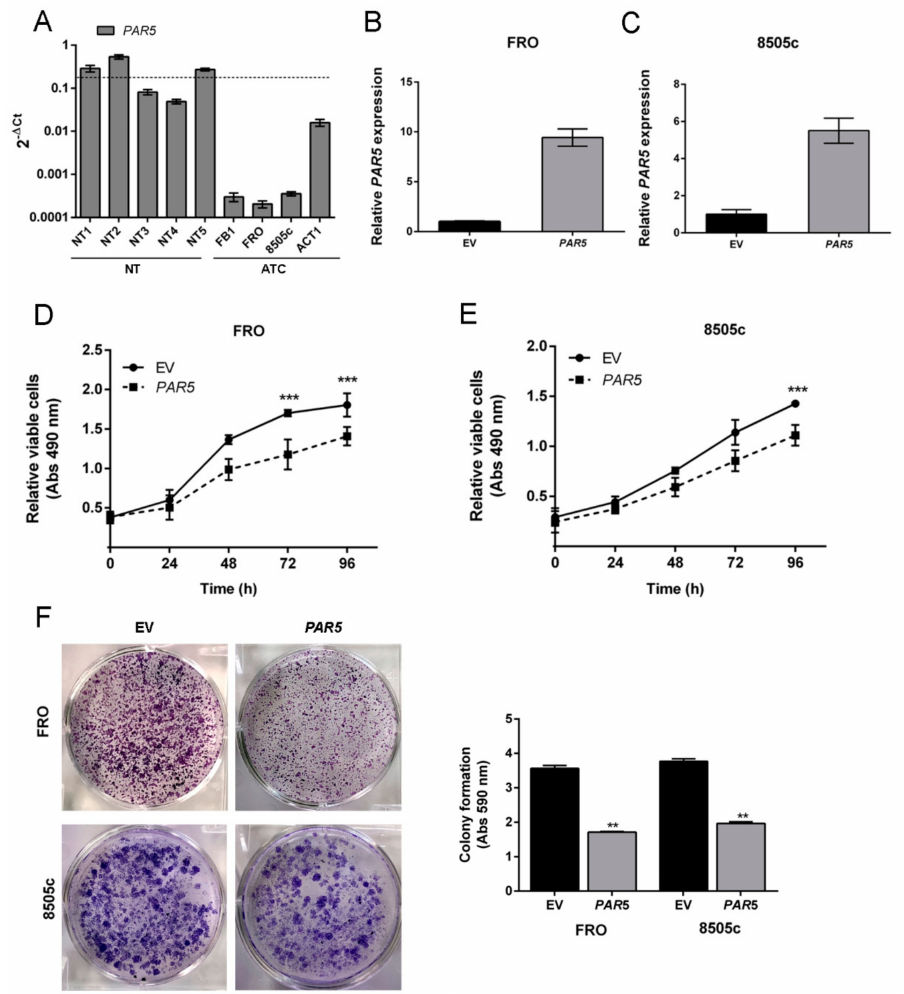
Figure 3. PAR5 reduces cell proliferation of thyroid cancer cell lines. ( A ) qRT-PCR analysis of PAR5 levels in a set of human anaplastic thyroid cell lines, including FB1, FRO, 8505c, and ACT1. Data are reported as 2 − ∆ Ct values ± SD. ( B , C ) qRT-PCR analysis performed on FRO and 8505c cell lines stably expressing PAR5 or carrying the corresponding empty vector (EV). Data were compared to EV, set equal to 1, and reported as 2 − ∆∆ Ct values ± SD. ( D , E ) Cell growth analysis of FRO and 8505c cells stably expressing PAR5 or carrying the corresponding EV. Cell number was evaluated at 24, 48, 72, and 96 h after seeding. Values were obtained from three independent experiments. Data are reported as mean ± SD. 2-way ANOVA test (Bonferroni post-test: PAR5 vs. EV, 96 and 72 h, ***, p < 0.001 in FRO cell line, PAR5 vs. EV, 96 h, ***, p < 0.001 in 8505c cell line). ( F ) A representative image of colony formation assays in FRO and 8505c cells transiently transfected with PAR5 or the corresponding EV is reported in the left panel. Cells were stained with crystal violet after 3 weeks of selection with G418. Quantitation of colony assay was performed by dissolving crystal violet solution in 0.1% SDS and measuring the absorbance at 590 nm. The results are reported as a mean of three independent experiments (right panel). t -test: **, p < 0.01( PAR5 vs. EV, in FRO and 8505c